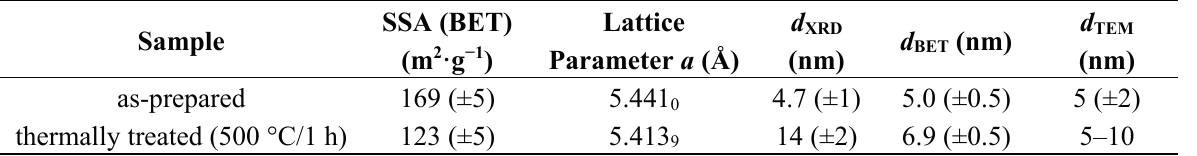
Figure 2. HR-TEM image of the as-prepared CeO 2 nanopowders at ( a ) low and high ( b ) magnification. Figure 2b corresponds to the squared area of Figure 2a. Reprinted from [11] with permission. Table 1. Summary of CeO 2 nanoparticle properties before and after thermal treatment at 500 °C. The lattice parameter a and the crystallite sizes d XRD were determined by high resolution synchrotron XRD and full pattern Rietveld refinement. The BET diameter, d BET , was calculated from specific surface area (SSA) measurements, assuming spherical particles and using the 5 points BET method. The TEM diameter, d TEM , was estimated from high resolution electron transmission microscopy